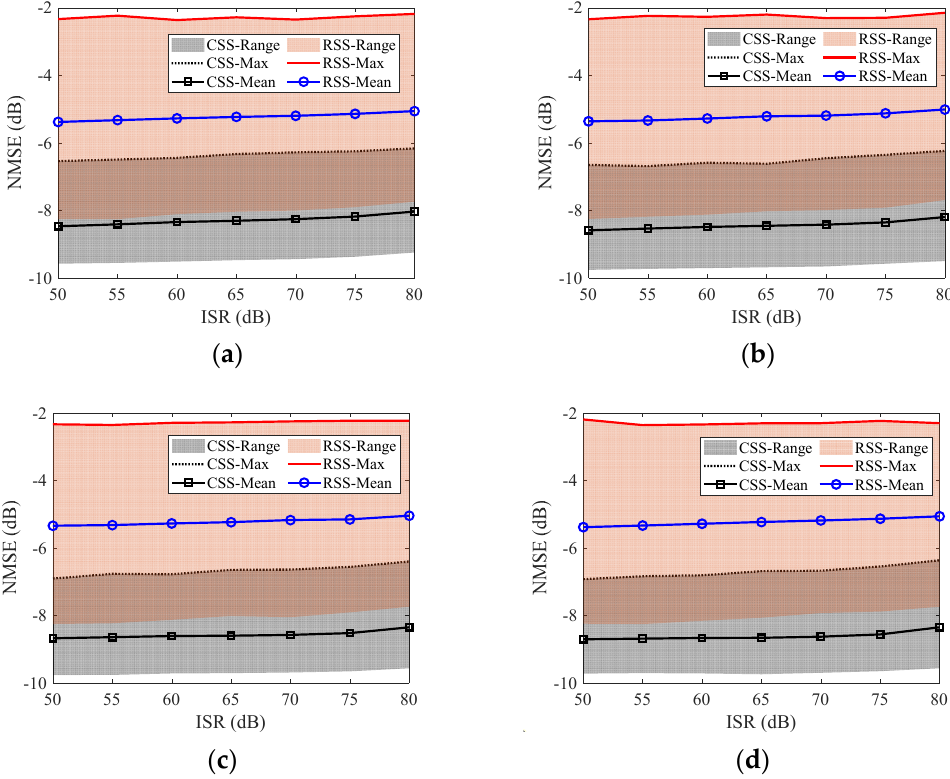
Figure 25. NMSEs of the proposed cognitive sparse imaging method and the RSS method against ISRs with random WBI parameters at the ( a ) second loop, ( b ) fourth loop, ( c ) sixth loop, and ( d ) eighth loop.